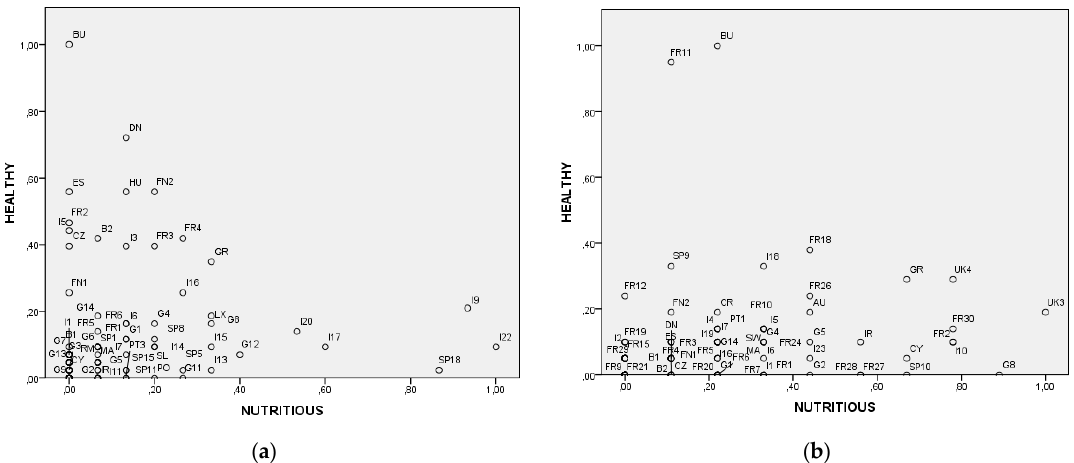
Figure 3. Healthy and Nutritious focus of Rural Development Programmes. ( a ) 2007–2013 Rural Development Programmes (RDP): Bulgaria (BU) RDP had the highest value of Healthy Food focus with 43, and a 2007–2013 Italian (I22) RDP had the highest value of Nutritious Food focus with 15 ( b ) 2014–2020 Rural Development Programmes (RDP): Bulgaria (BU) RDP had the highest value of Healthy Food focus with 21, and a 2014–2020 British (UK3) RDP had the highest value of Nutritious Food focus with 9.